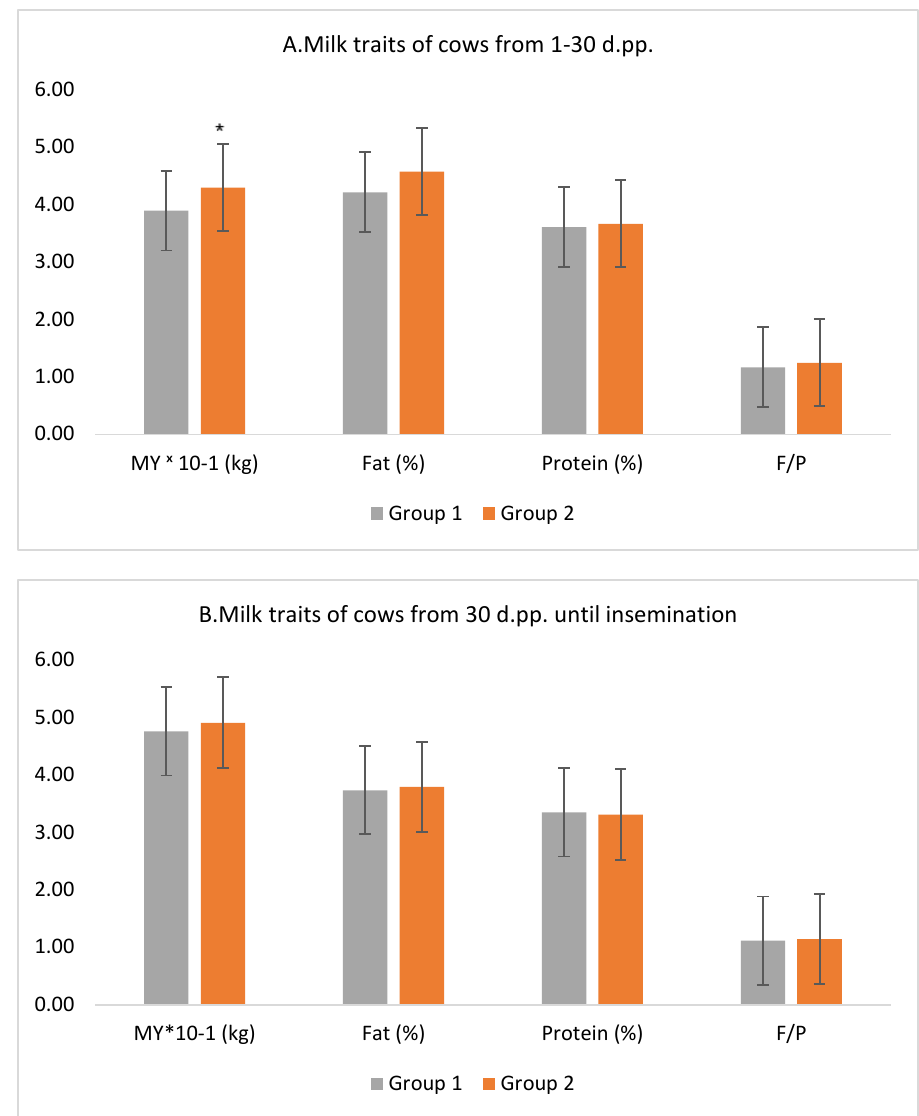
Figure 1. Milk characteristics of cows by milk lactose level. ( A ). 1–30.p.p., ( B ). From 30 d.p.p. until insemination. Group 1—milk lactose < 4.70%, Group 2—milk lactose ≥ 4.70%. MY—milk yield. F/P—milk fat/protein ratio. d.p.p—days post partum. The difference between the groups is statistically significant—* P < 0.005.